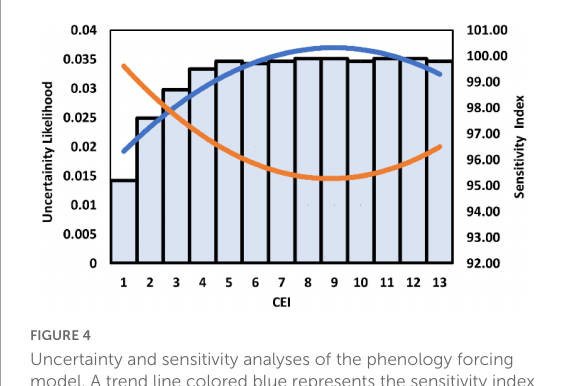
FIGURE4 Uncertainty and sensitivity analyses of the phenology forcing model. A trend line colored blue represents the sensitivity index values as mentioned on the right vertical axis. While the orange-colored trend line shows the uncertainty likelihood in the model as mentioned on the left vertical axis. The climate extreme index ( CEI ) is mentioned on the x